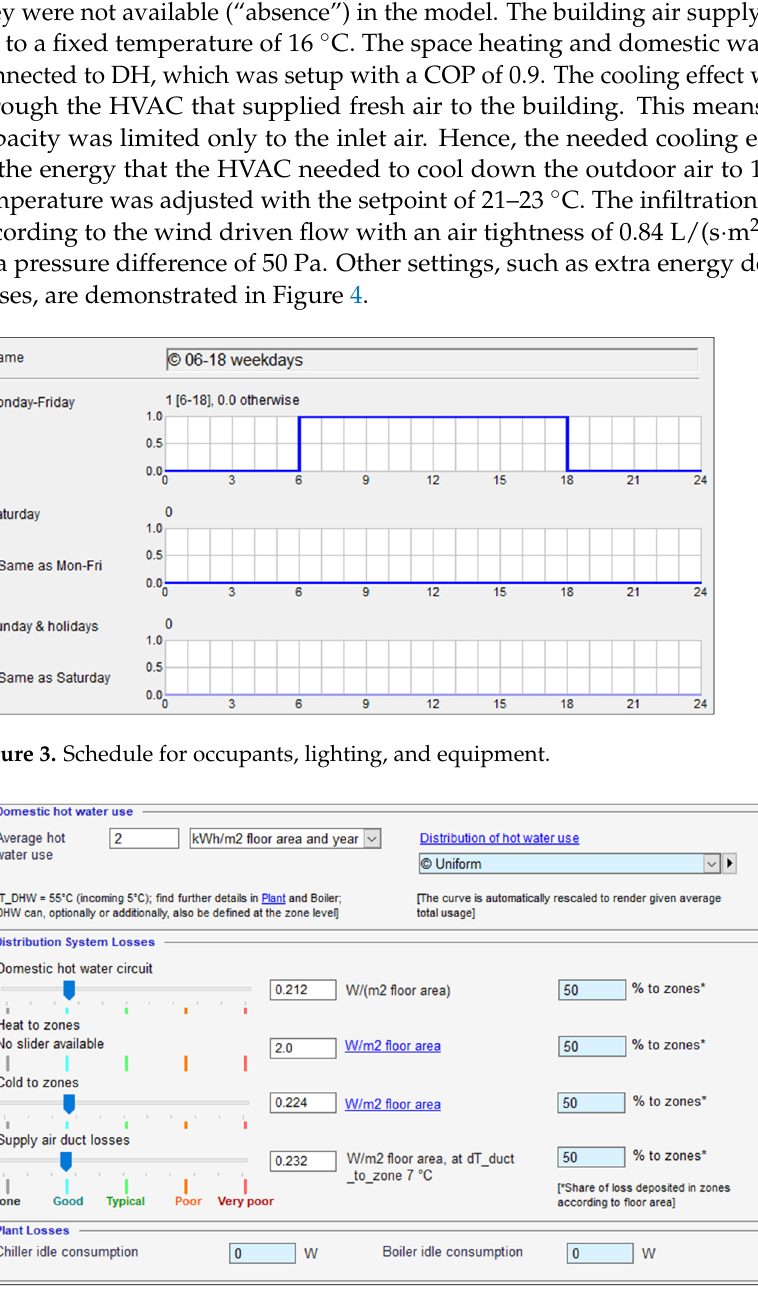
Figure 4. Distribution system losses in model as well as hot water usage.